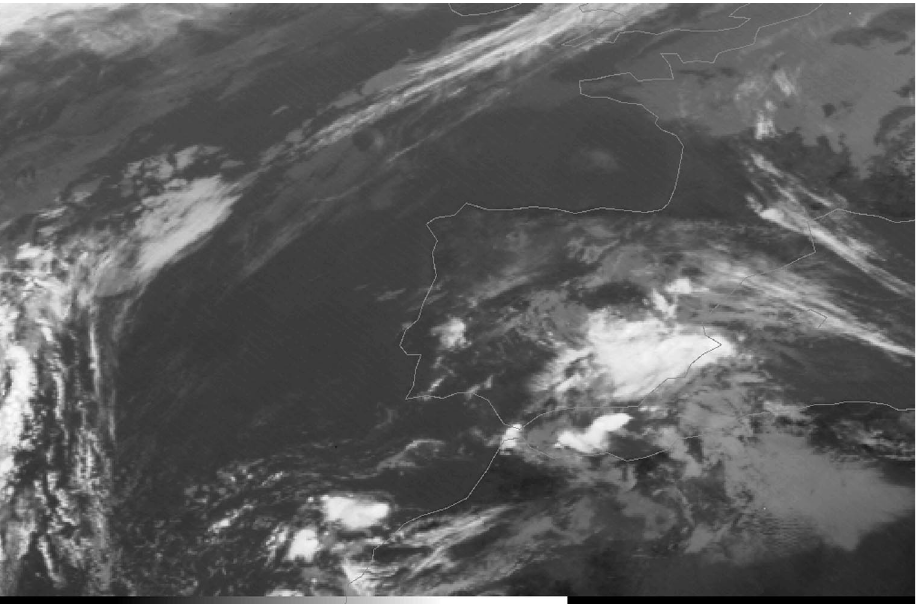
Fig. 10. Same as Fig. 9 except for 2 February 1993 at 1100